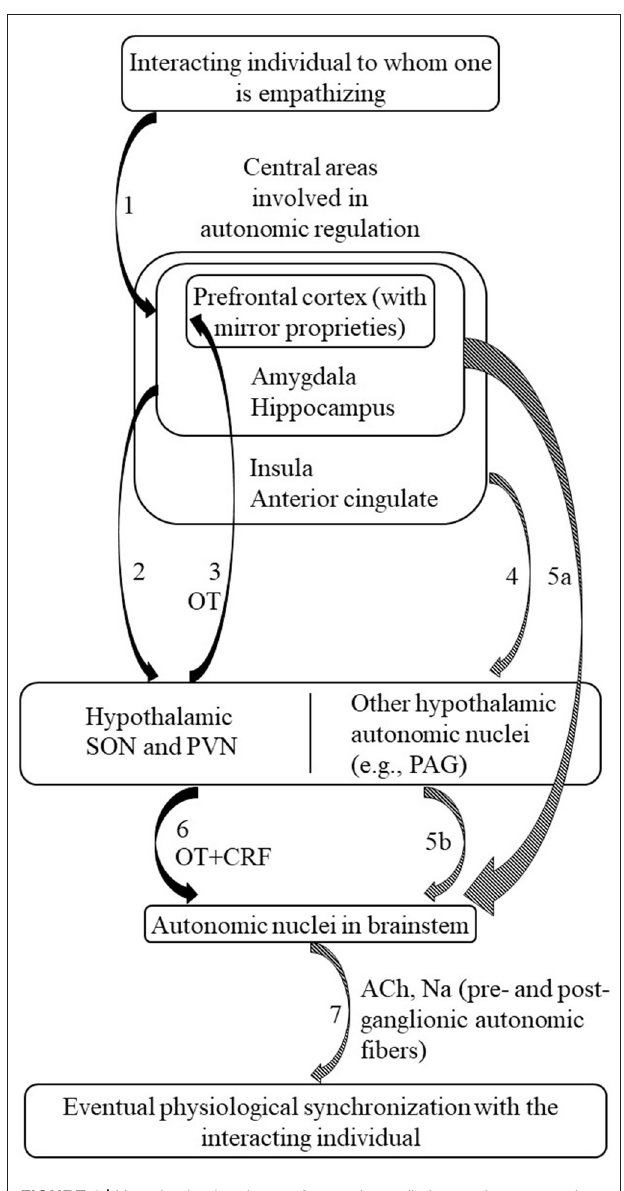
FIGURE 1 | Hypothesized pathway of oxytocin mediation on the autonomic nervous system, in terms of physiological synchronization among interacting individuals. (1) The person to whom one empathizes (or to whom one is attached to/is socially engaged with/that is perceived relevant in ingroup-outgroup dynamics) impacts firstly on the brain areas involved in processing social environmental stimuli, i.e., the prefrontal cortex, amygdala, and hippocampus (Uvnäs-Moberg et al., 2005). (2) The prefrontal-amygdala-hippocampus complex influences oxytocin release in PVN and SON hypothalamic nuclei (Uvnäs-Moberg et al., 2005). (3) In turn, oxytocin released in PVN and SON influences the mirror system expressed in the prefrontal structures (Festante et al., 2020). Namely, this pseudo-circular feedback and feedforward system should facilitate mirroring, possibly by making the mirror neurons more sensitive. (4) CAN and its related paralimbic nuclei, including the prefrontal-amygdala-hippocampus complex, directly regulates hypothalamic autonomic nervous system nuclei (Benarroch, 2012). (5) The prefrontal structures and the amygdala-hippocampus complex directly